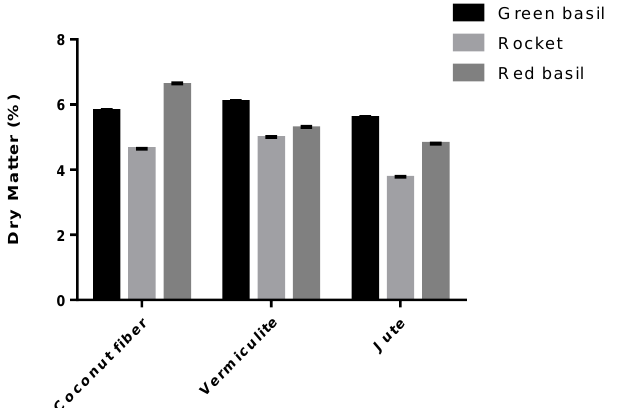
Figure 4. Dry matter of green basil, rocket, and red basil microgreens grown on three different substrates. Values, subjected to two-way ANOVA, are means ± SE (n = 6).